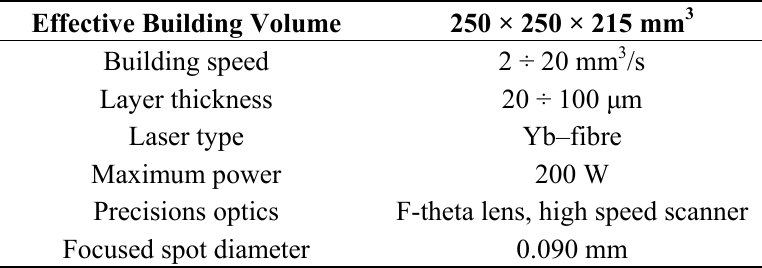
Table 9. EOSINT M270 titanium version specifications.